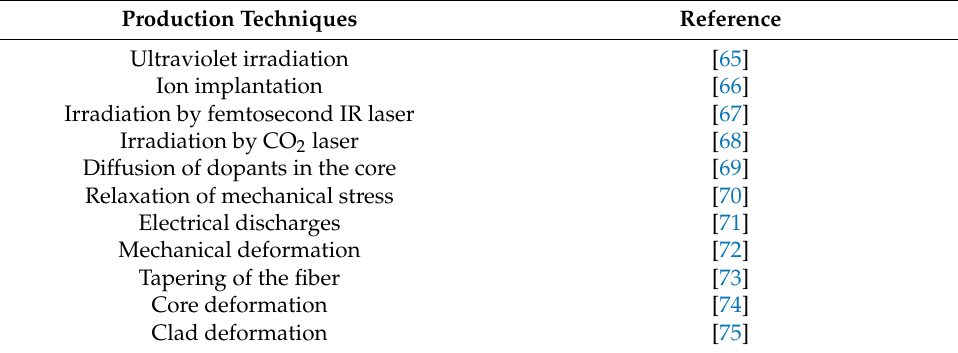
Table 2. Summary of principal fabrication techniques for long period